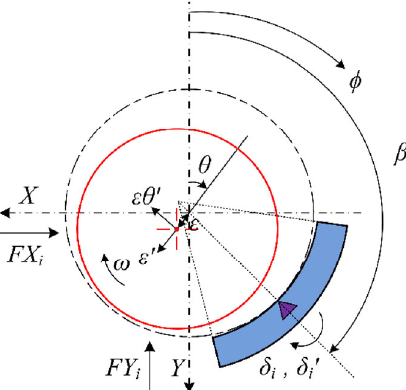
Fig. 2 Coordinate system of a single